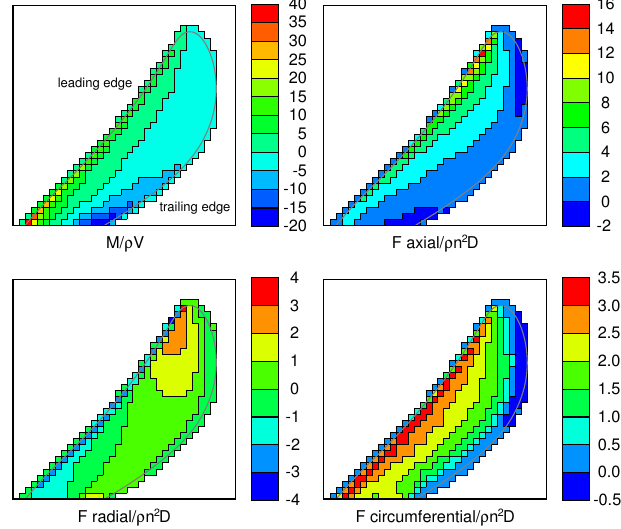
Figure 3. The distribution of M / ρ V and F / ρ n 2 D for DTMB P4384 at J = 0.6. In the white regions, M and F are exactly zero. The grey line is the outline of the swept volume of the